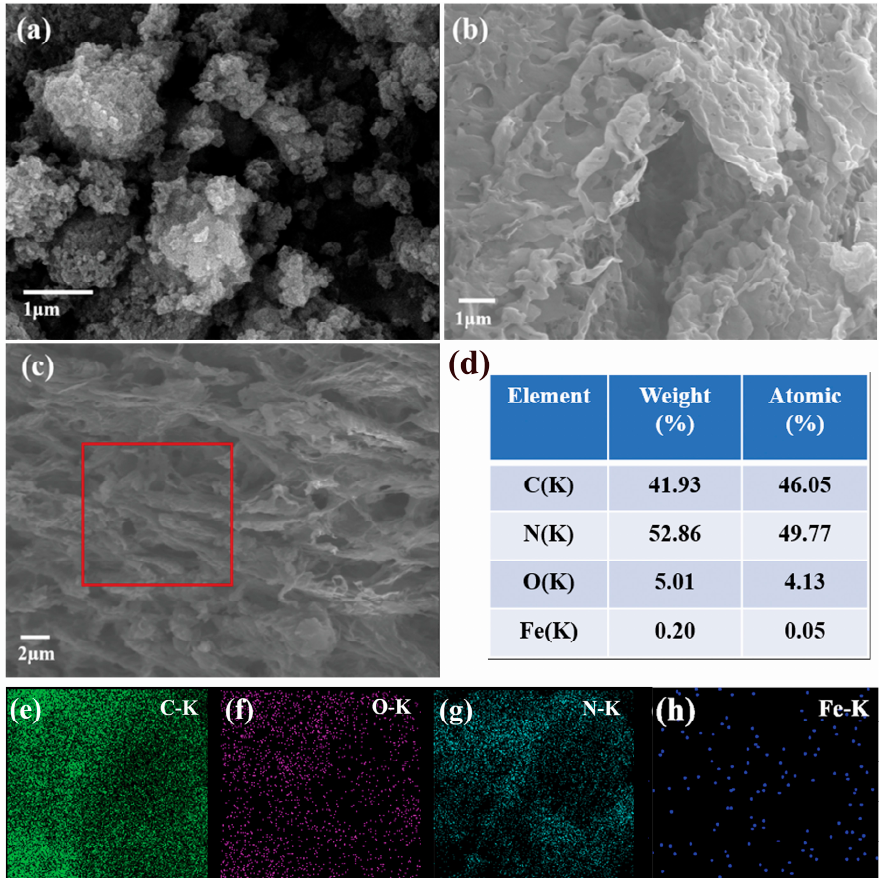
Figure 4. SEM images of ( a ) FeTCPP, ( b ) CNNS, and ( c ) 3% FeTCPP@CNNS; ( d ) EDS at 3% FeTCPP@CNNS (red area in fi gure ( c )); ( e – h ) The corresponding EDS elemental mapping of C, O, FeTCPP@CNNS (red area in figure ( c )); ( e – h ) The corresponding EDS elemental mapping of C, N, and Fe elements in 3% FeTCPP@CNNS composites. O, N, and Fe elements in 3% FeTCPP@CNNS